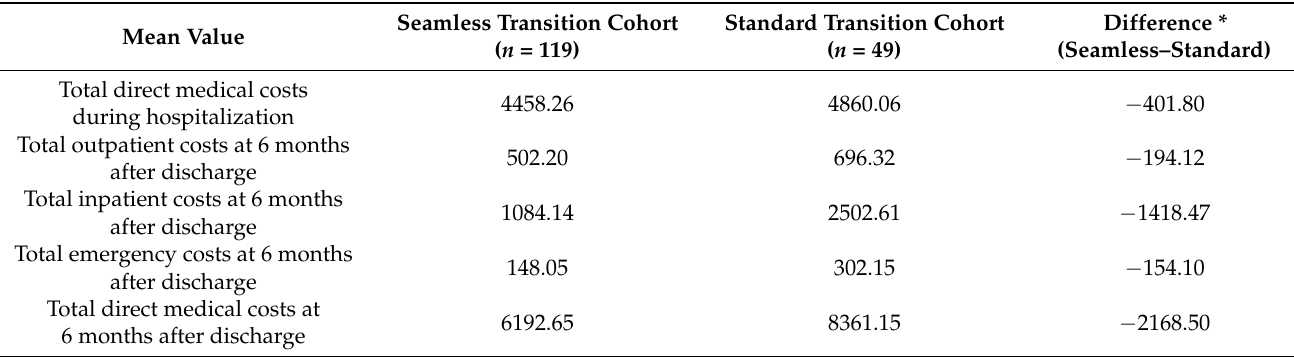
Table 4. Economic burdens and difference in various medical costs during hospitalization and after discharge in seamless transition cohort and standard transition cohort ( n =